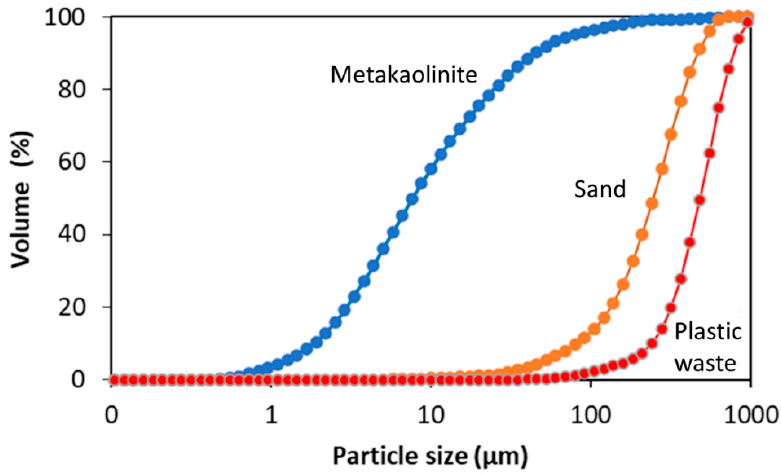
Figure 4. Overlap graph of granulometry curves in the metakaolinite, sand, and plastic